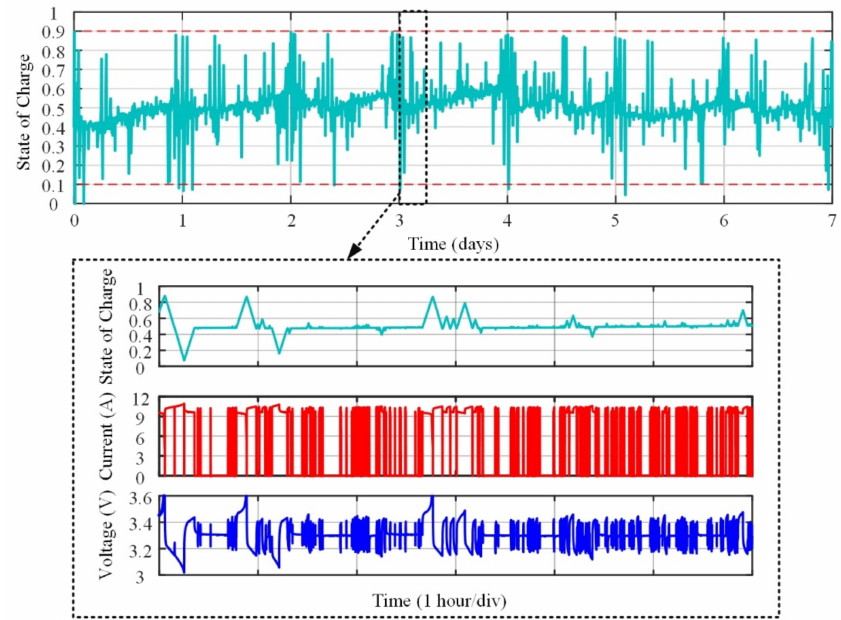
Figure 2. State of charge variation in the aging mission profile and the current and voltage response in the zoomed part.